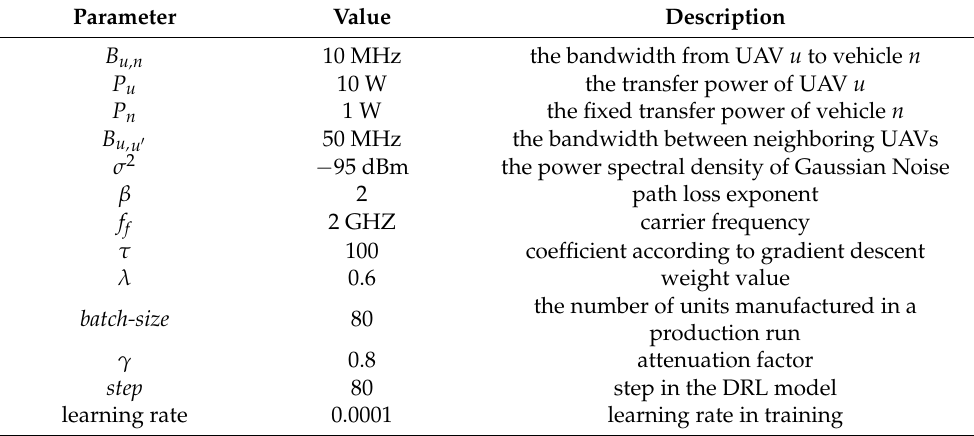
Table 1. The setting of variable